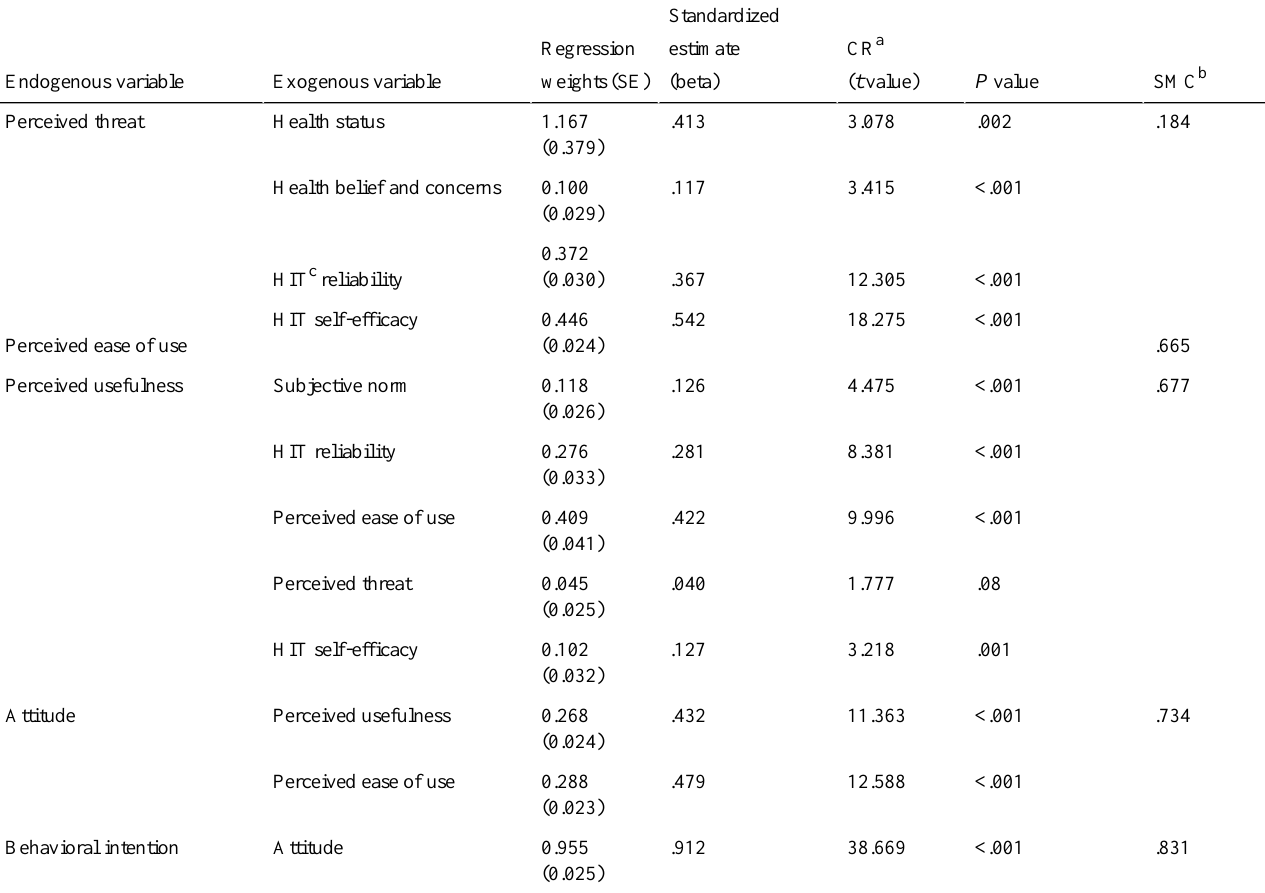
Table 5. Standardized estimates of the Health Information Technology Acceptance Model